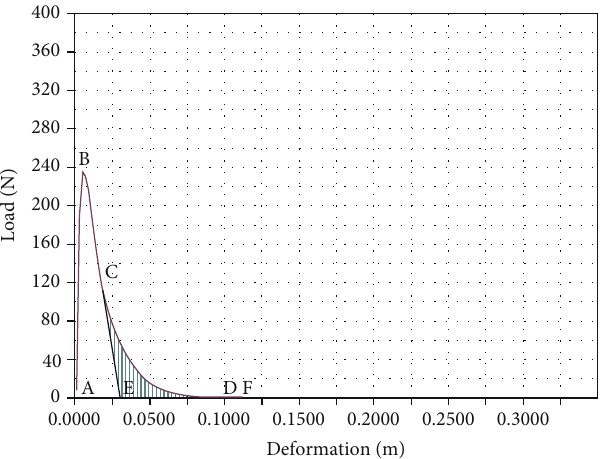
Figure 3: 1# tire rubber powder-modi fi ed asphalt viscosity test load-deformation